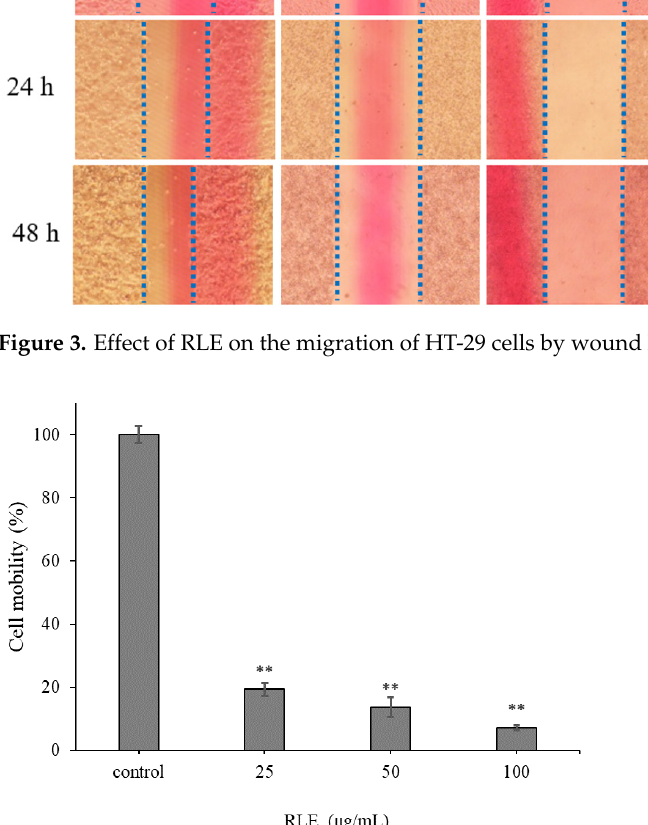
Figure 4. The effect of RLE on the migration of HT-29 cells (`x ± SD, n = 3), ** p < 0.01 vs. control group, the same